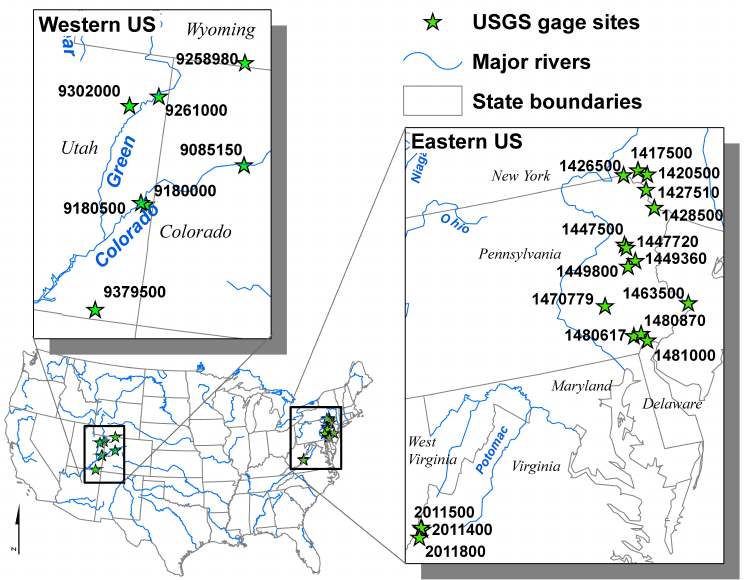
Figure 1. Study map showing U.S. Geological Survey river water temperature gauge locations for both the eastern and western (Upper Colorado River Basin) U.S. Numerical codes corresponds to the U.S. Geological Survey gauge